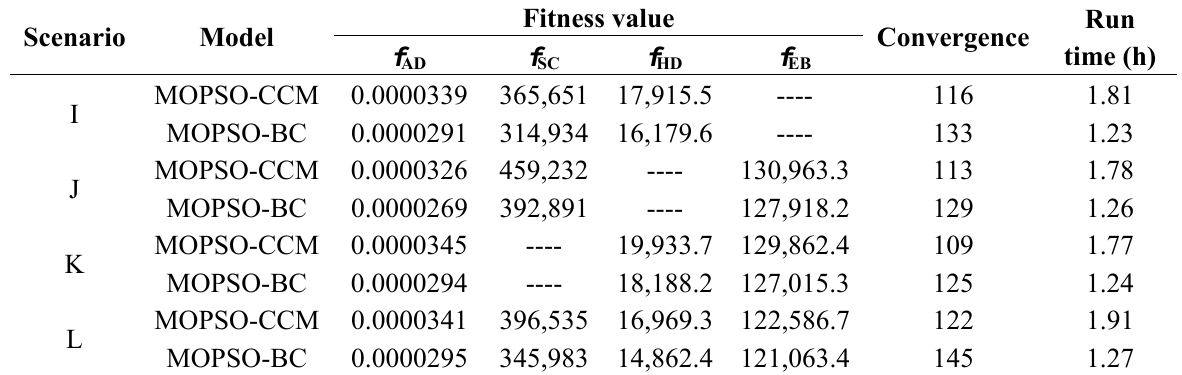
Table 10. The results obtained by MOPSO-CCM and MOPSO-BC with the four weighted scenarios.